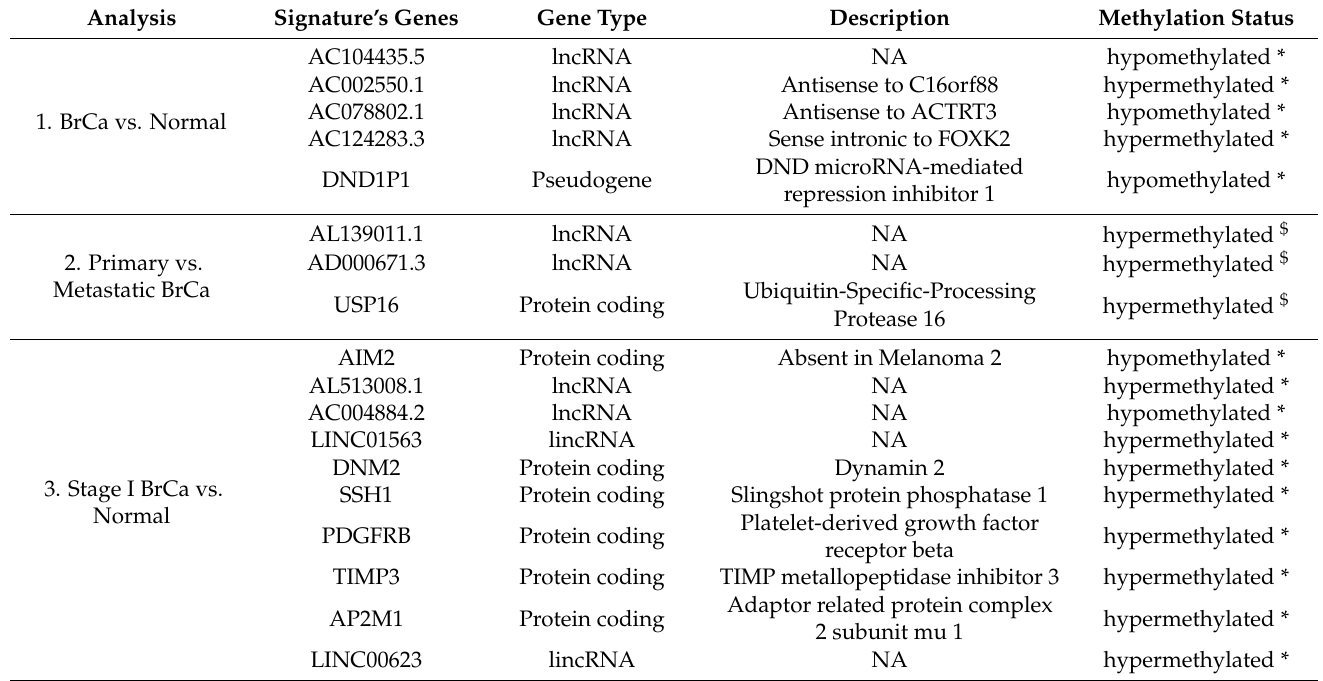
Table 1. Genes included in the predictive signatures and their methylation